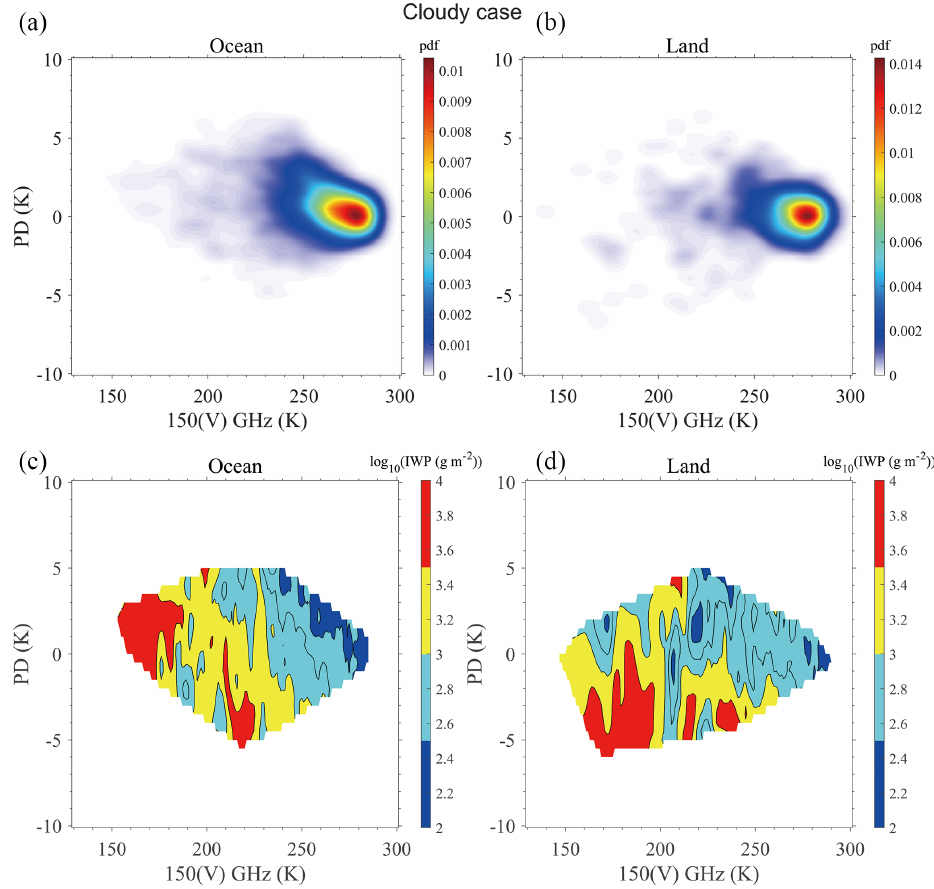
Figure 6. The PD–TB 150V density plots for the collocations in the cloudy scenes over the ocean (a) and land (b) . Panels (c) and (d) show the corresponding IWPs from 2C-ICE.